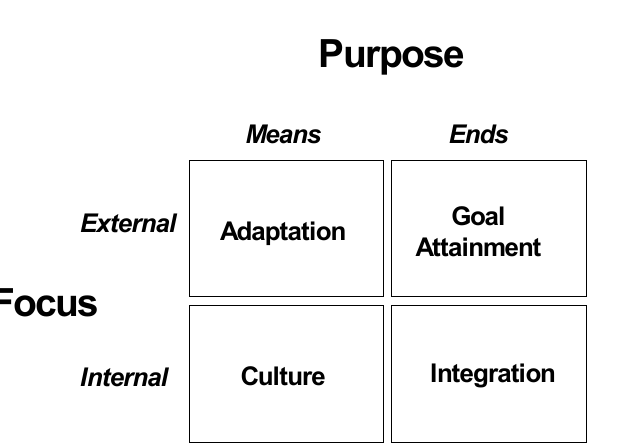
Figure 2: Parsons’ four functions